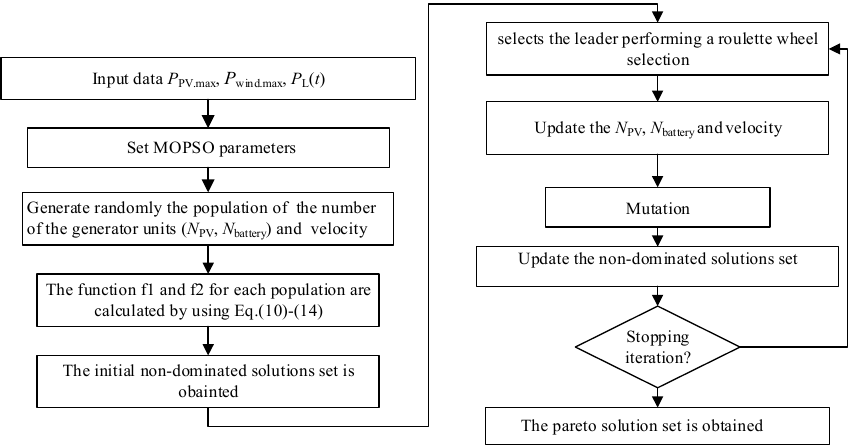
Figure 2. Flowchart of the multi-objective scheduling model.